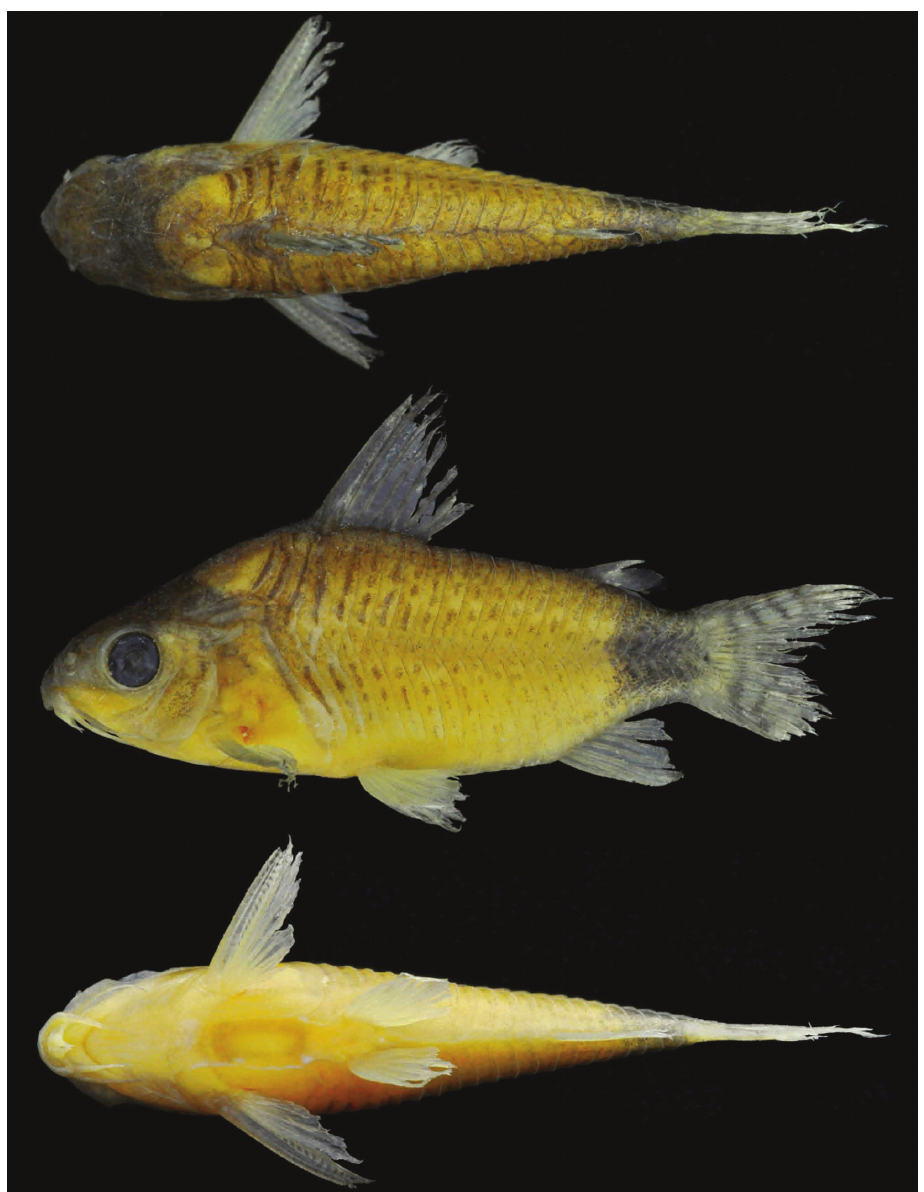
Fig. 2. Topotype of Corydoras guapore , ZUFMS-PIS 4000, 33.6 mm SL, Brazil, Mato Grosso State, rio Guaporé. Dorsal, lateral and ventral